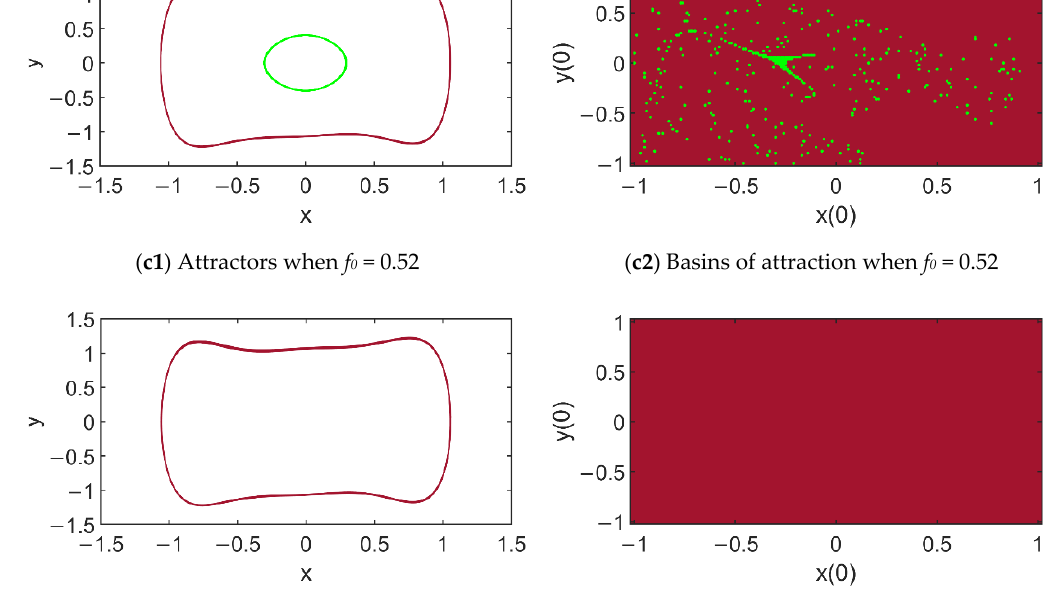
Figure 10. Sequences of attractors and their basins of attraction for f 0 ranging from 0.37 to 0.60.